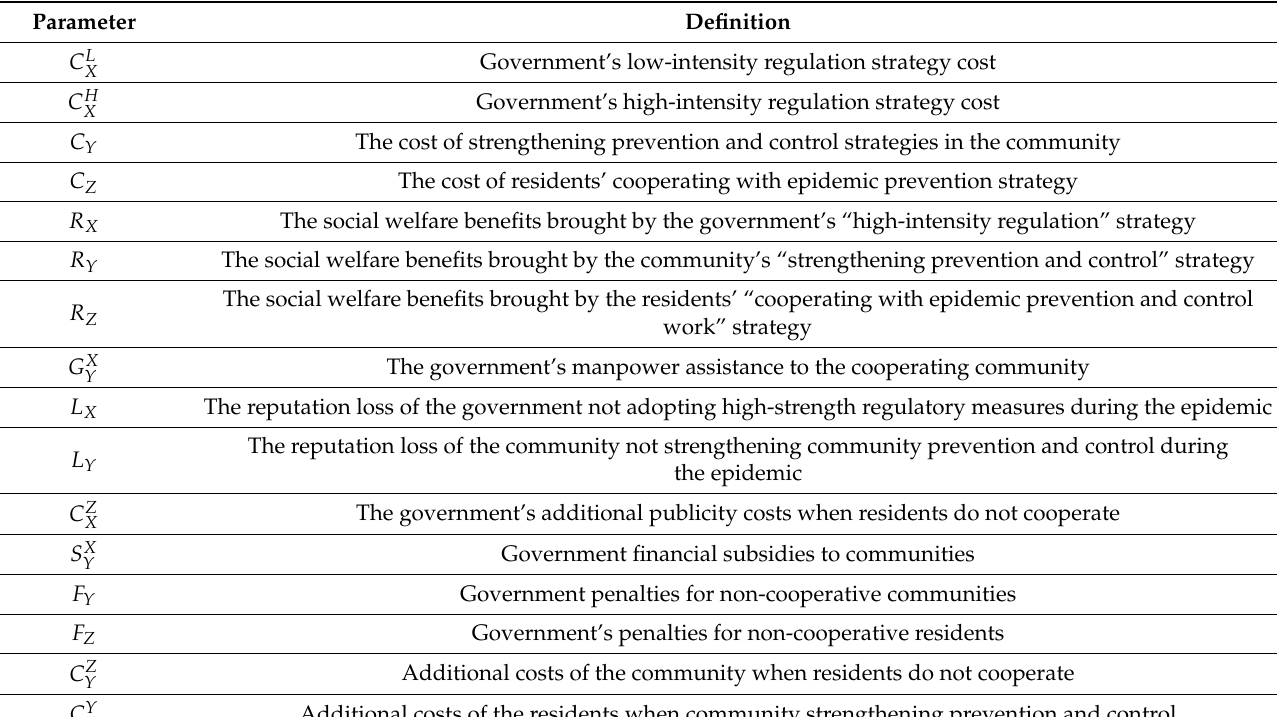
Table 1. Related parameters and